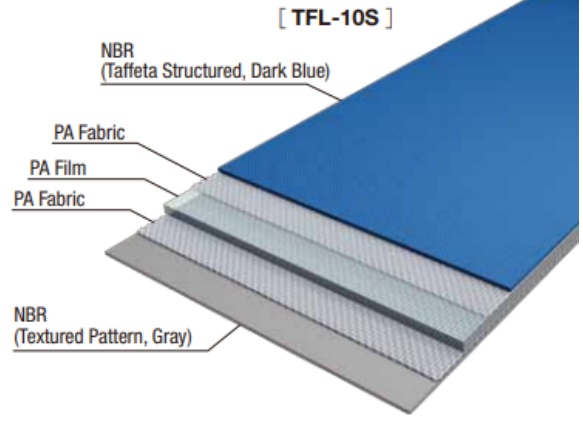
Figure 4. Belt specimen dimensions (in mm).